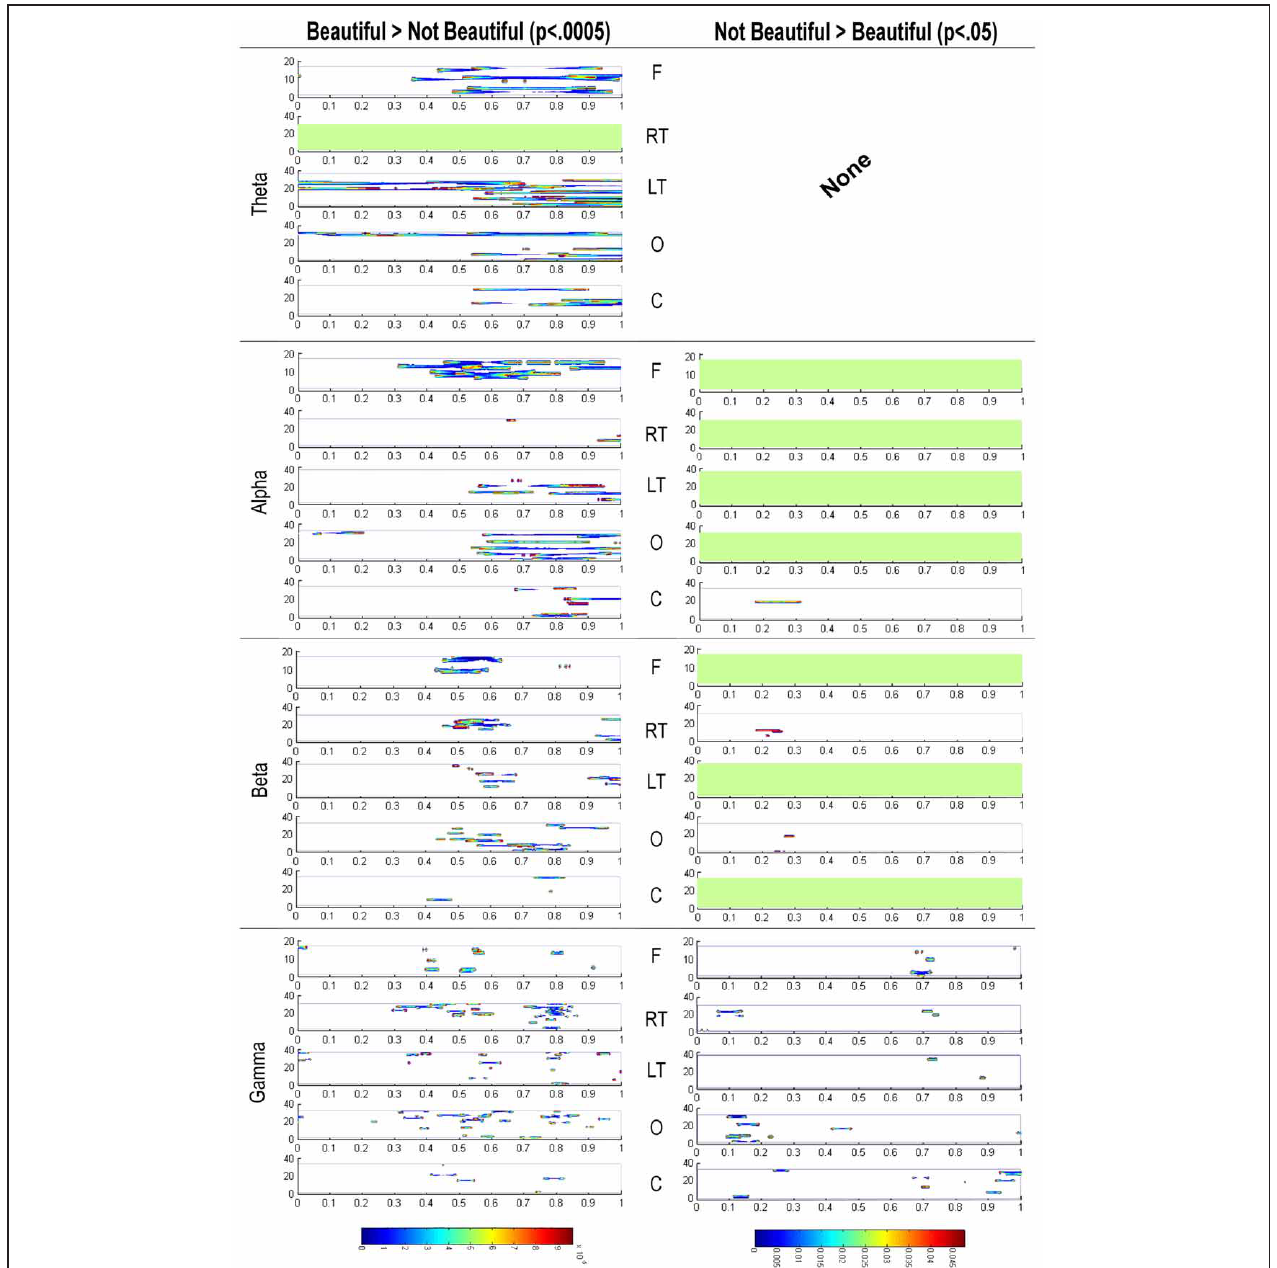
FIGURE 5 | Representation of the subtraction of oscillatory power related with stimuli rated as not beautiful from that related with stimuli rated as beautiful, and vice versa. Kruskal Wallis tests with FDR control were used in both cases. To underscore the difference in signification between both contrasts, we used a p < 0 . 0005 in the former, and a p < 0 . 05